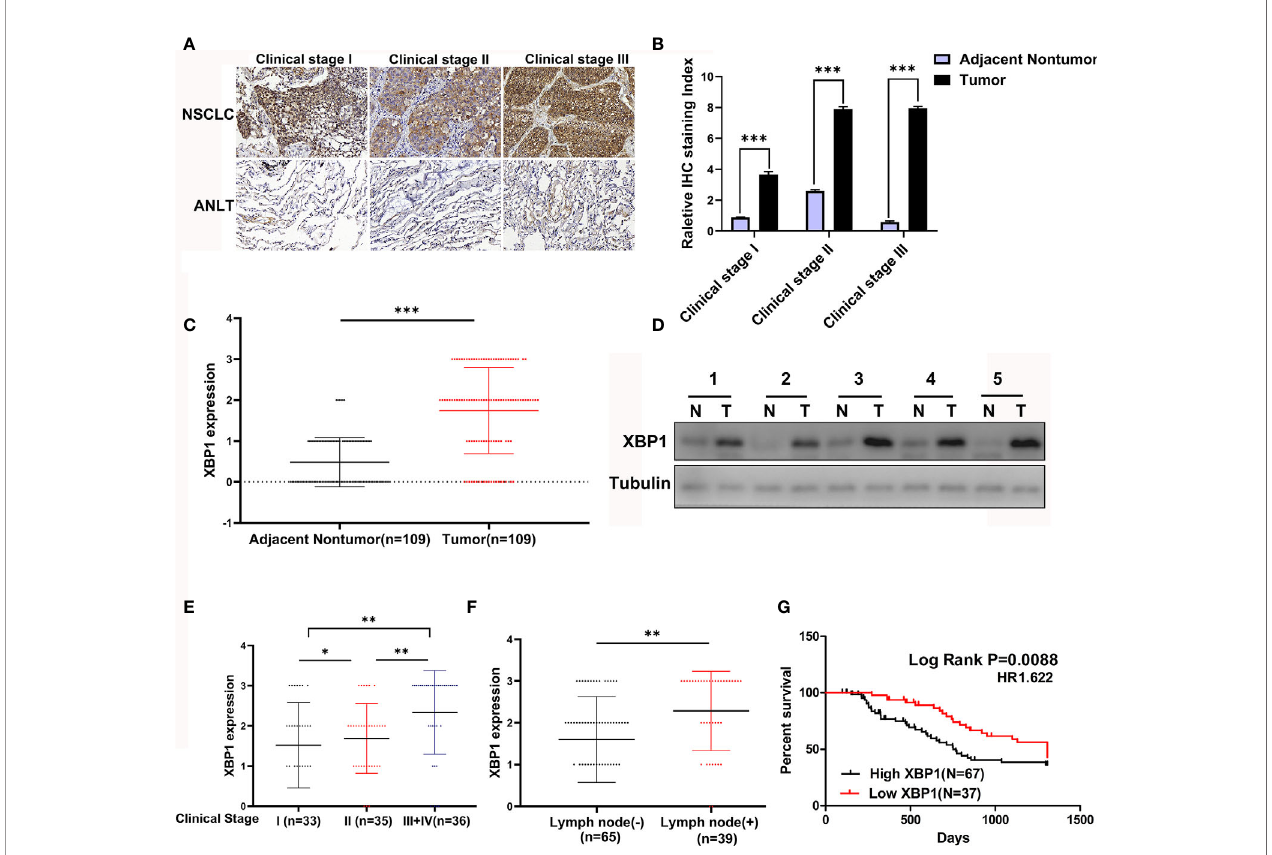
FIGURE 1 | XBP1 is upregulated in NSCLC tumor tissues and associated with poor prognosis. (A – C) Representative immunohistochemically stained images of human NSCLC tumor tissues and the matched adjacent normal lung tissues using anti-XBP1 antibody, and relative protein expression level of XBP1 in NSCLC tumor tissues compared to the matched adjacent normal lung tissues from 104 patients. (D) Western blot analysis of XBP1 expression in 5 paired human NSCLC tumor tissues (T) compared to the matched adjacent normal lung tissues (N). (E, F) advanced TNM stage or Lymph node metastasis NSCLC tumors had higher XBP1 expression level. (G) Kaplan-Meier overall survival curves for NSCLC patients indicated the high XBP1 expression level is correlated with worse overall survival rates. Data were represented as the mean ± SEM of three independent experiments. * P < 0.05, ** P < 0.01, *** P <